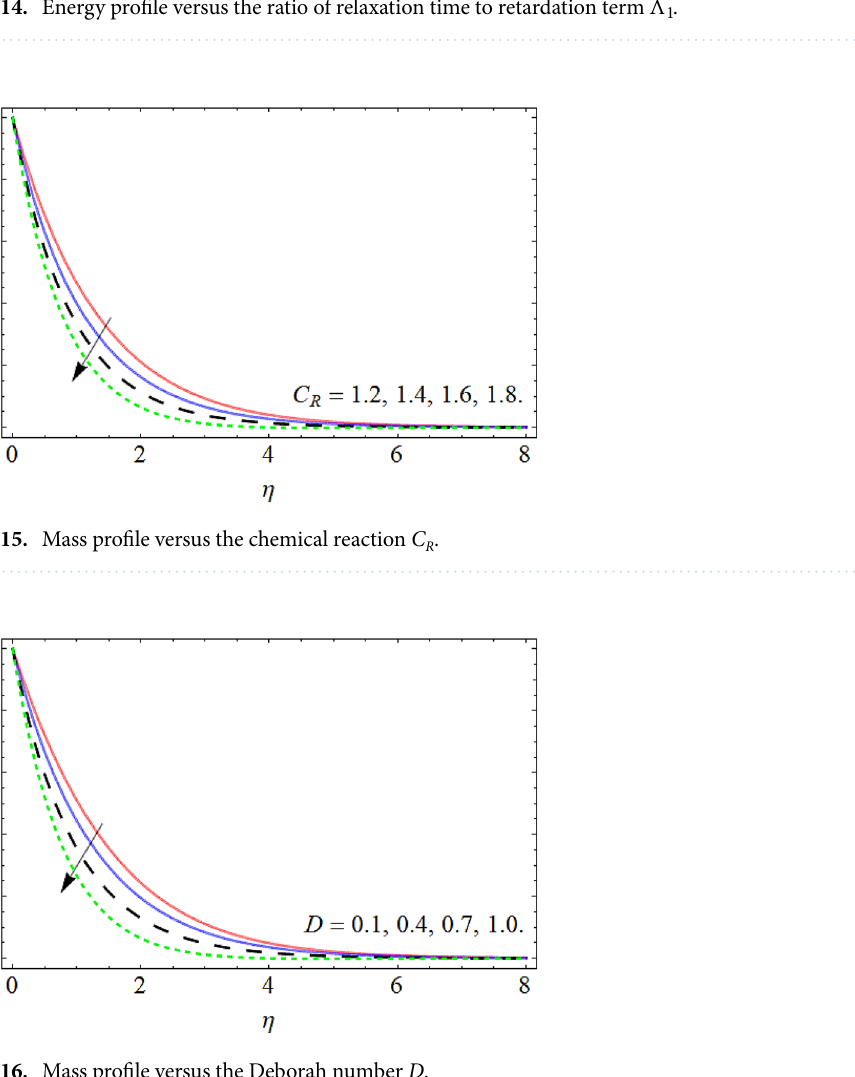
Figure 14. Energy profile versus the ratio of relaxation time to retardation term (cid:31) 1 .